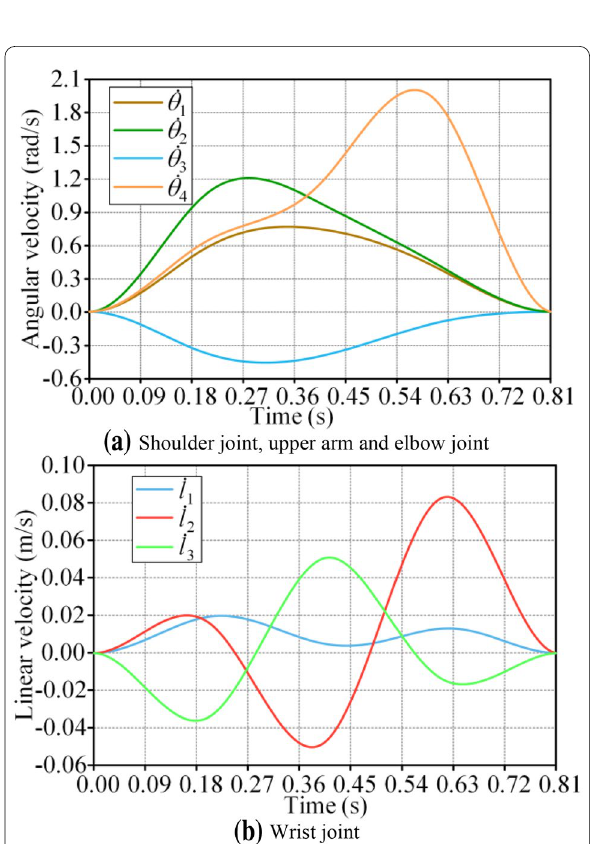
Figure 8 The velocity profile of each joint using quintic